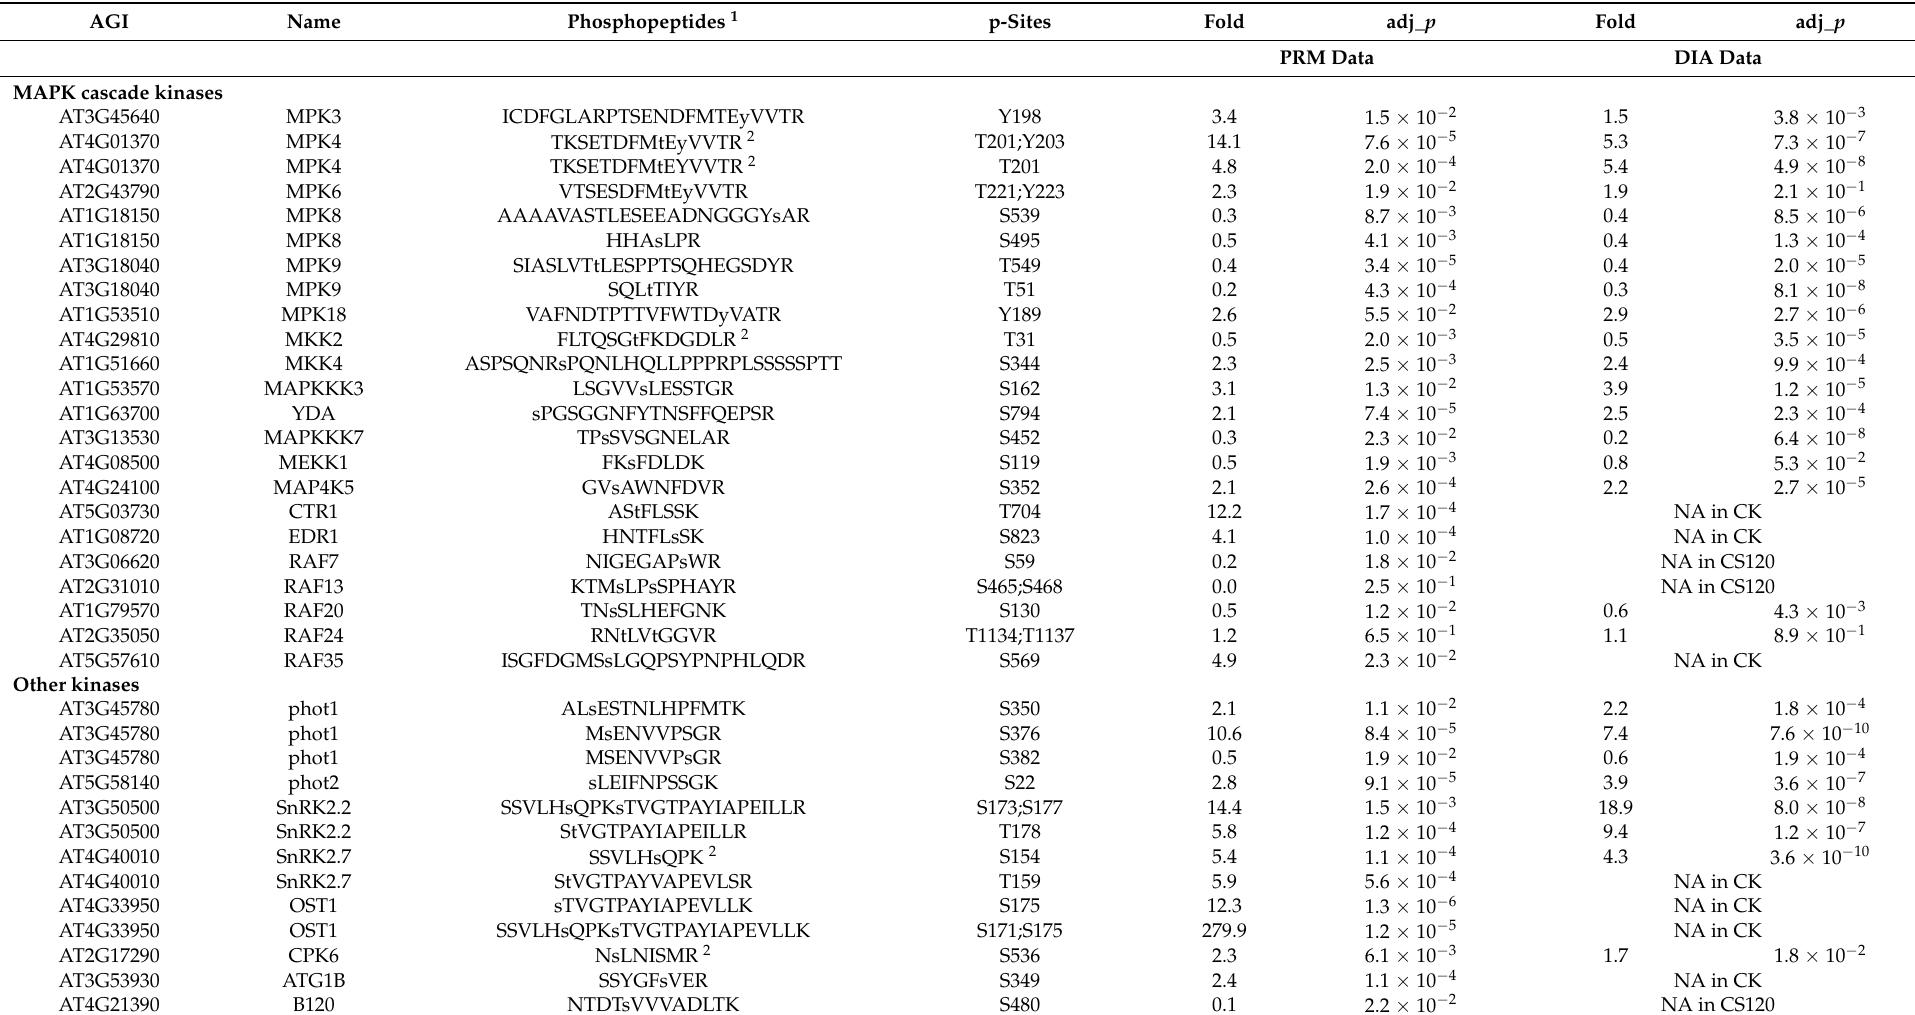
Table 2. Representative cold-responsive phosphopeptides validated by PRM (120-min time